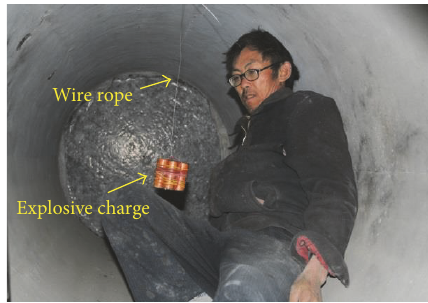
Figure 8: Electric